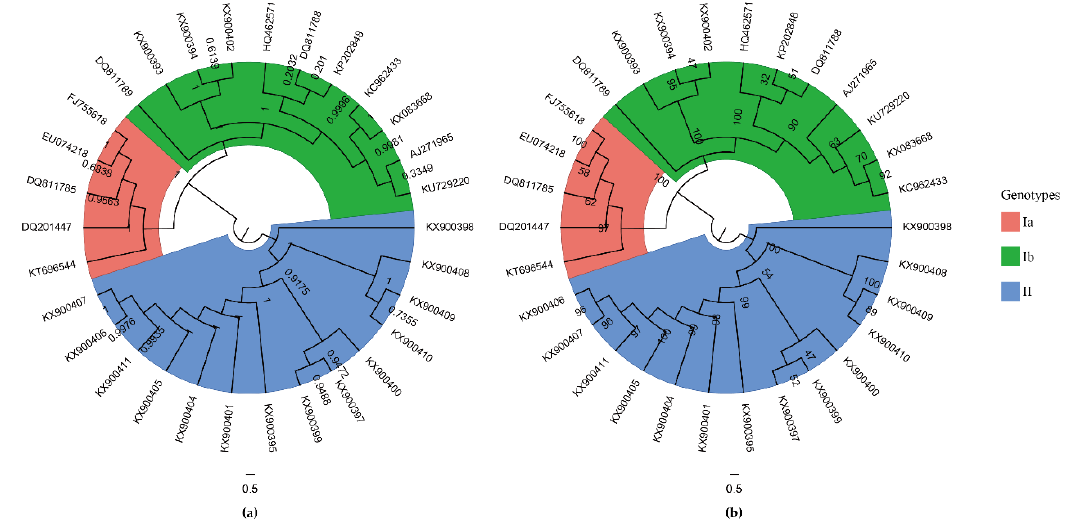
Figure 1. Phylogenetic trees of the complete coding sequence (CDS) of TGEV. ( a ) Bayesian inference tree of the complete CDS of TGEV. Posterior probability values calculated by MrBayes are shown at each node. ( b ) Maximum likelihood tree of the complete CDS of TGEV. Bootstrap support values computed by RAxML are indicated on the nodes of tree. Scale bar at the bottom of the figure indicates a length corresponding to 0.5 nucleotide substitutions per site. The colored sectors represent three genotypes of TGEV.